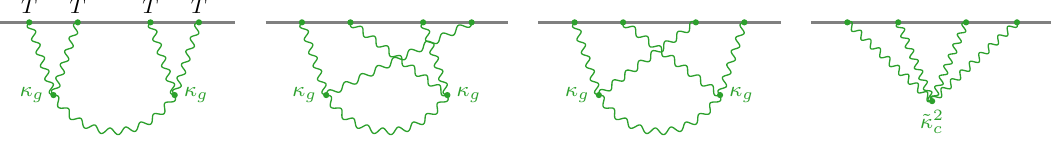
Figure 11: Illustration of the couplings involved in the exchange and contact contri- butions to the four-point function of the stress